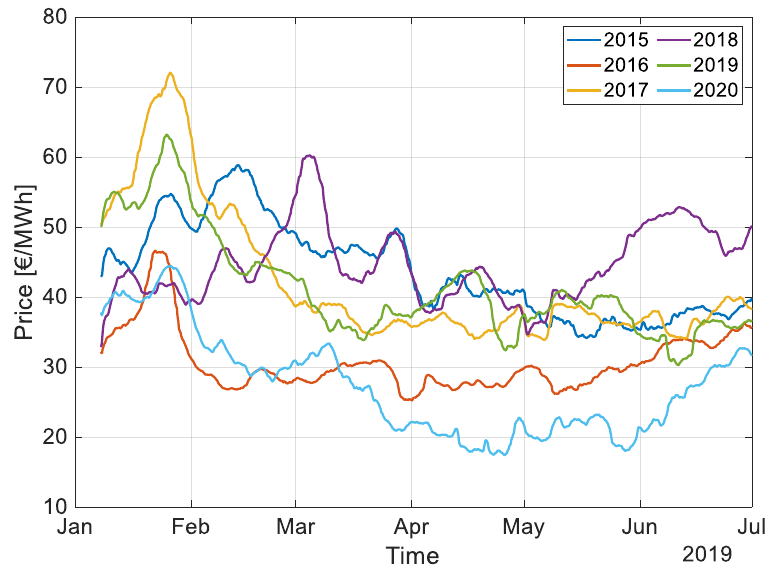
Figure 8. Pan-European load-weighted moving average of all bidding zones.